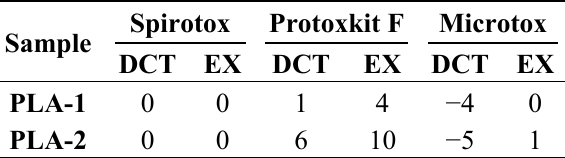
Table 1. Toxicity of tested